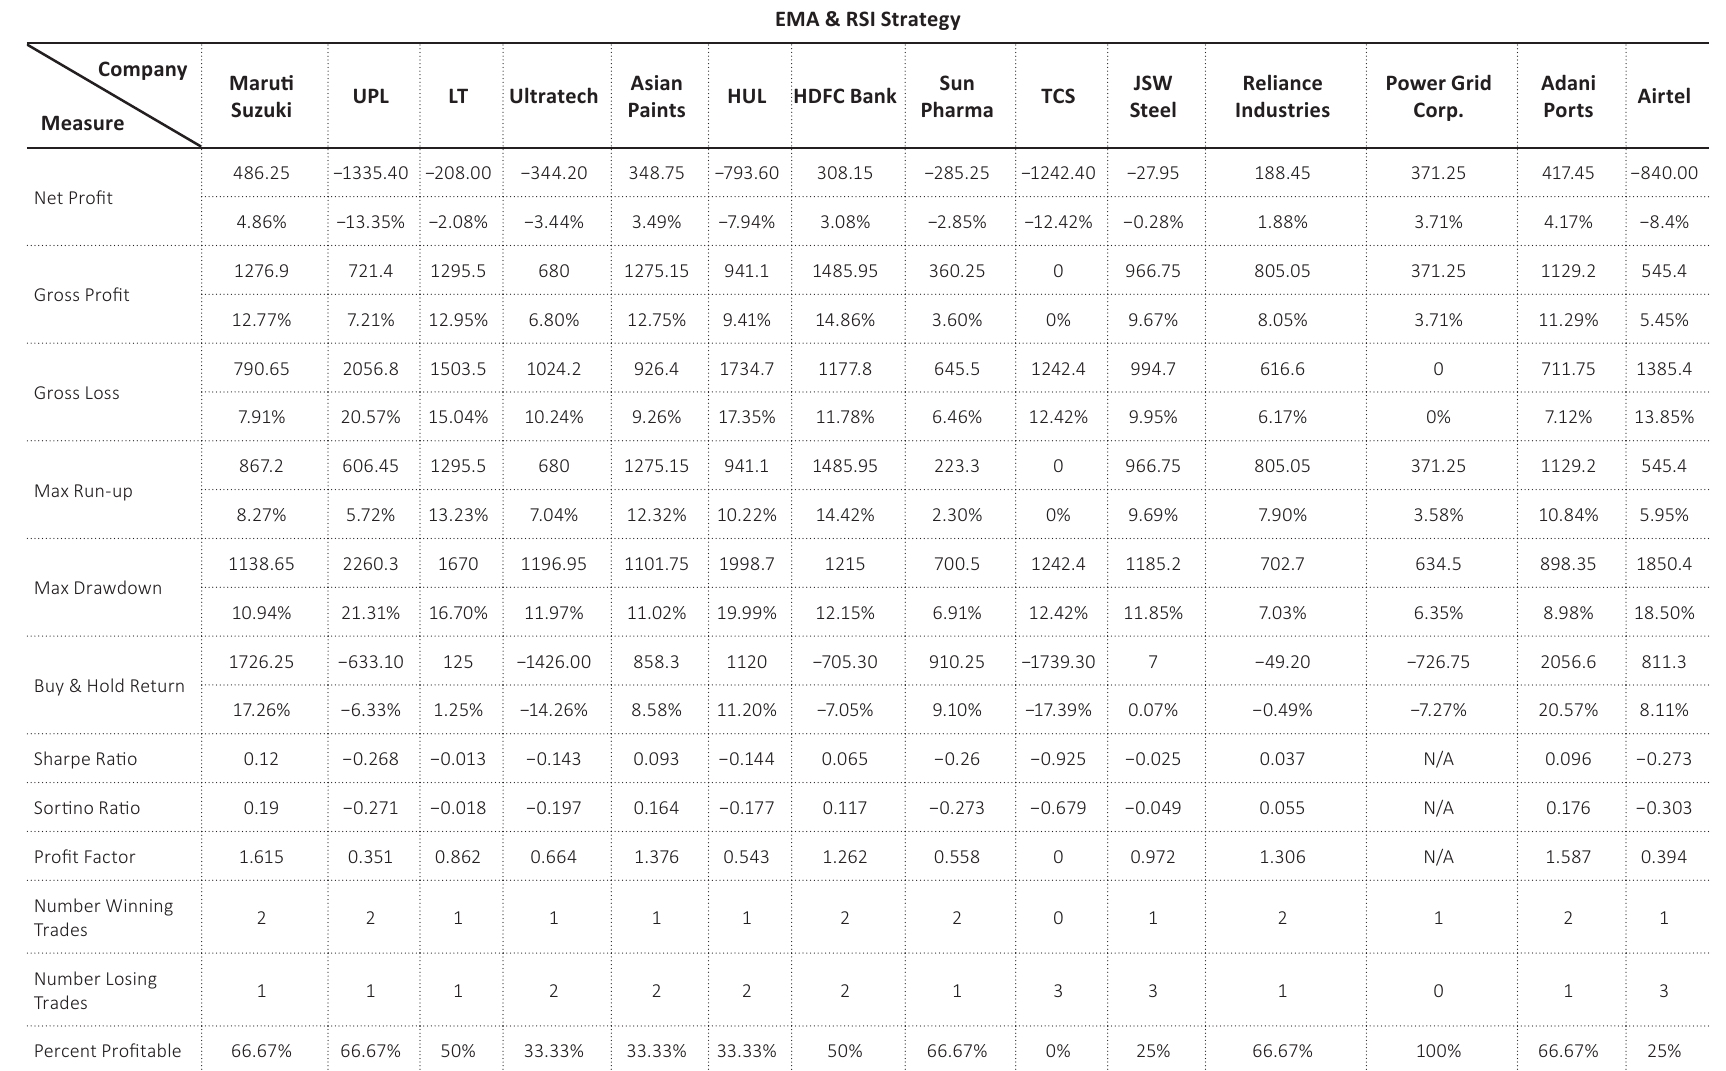
Table A3. EMA and RSI Strategy